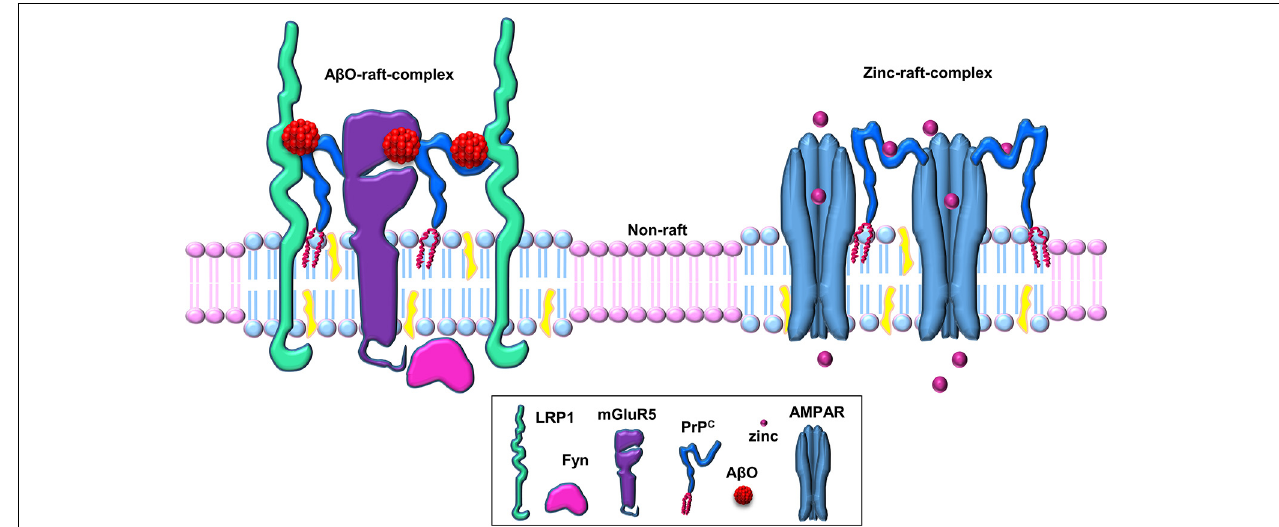
transmembrane proteins (such as AMPA receptors, LRP1, mGluR5, etc.) in these multi-protein complexes in a ligand-dependent manner (here shown for the ligands zinc and A β oligomers within separate raft-based